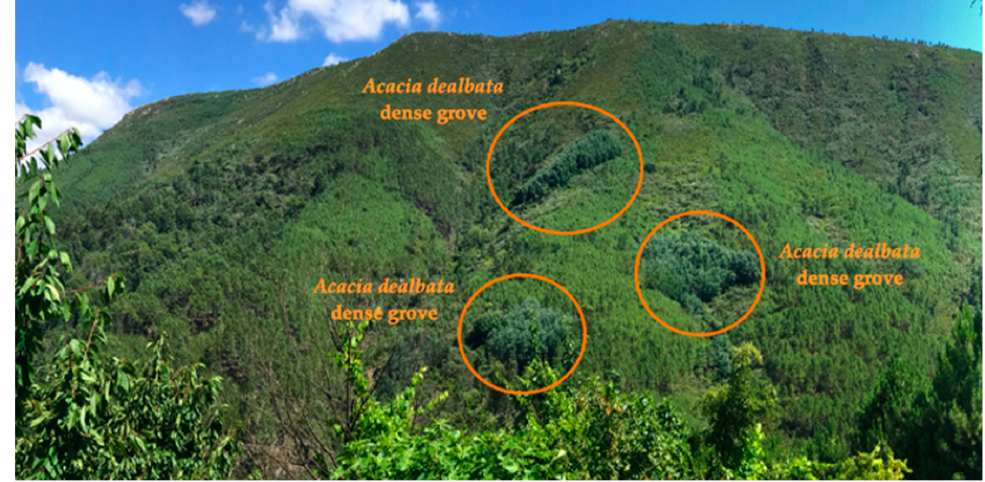
Figure 2. Acacia dealbata groves on the slope opposite the road from Casal do Rei to Cabeça. Acacia groves are identifiable by their very characteristic greenish color.